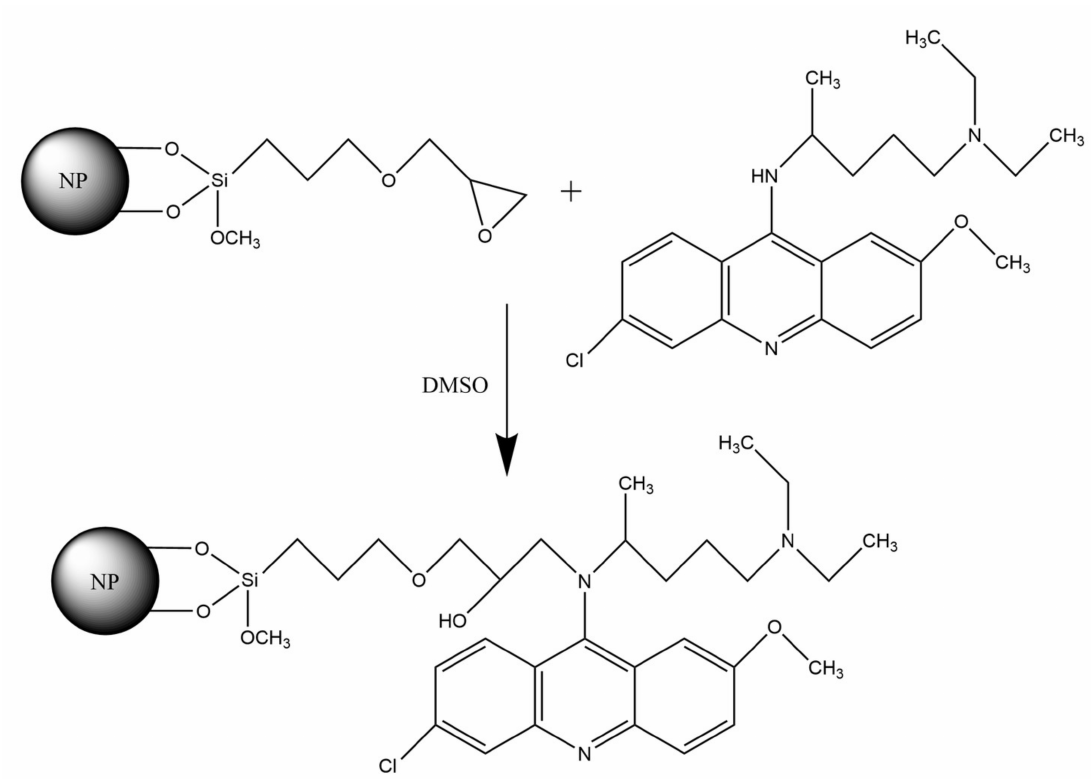
Figure 4. Quinacrine immobilization diagram.